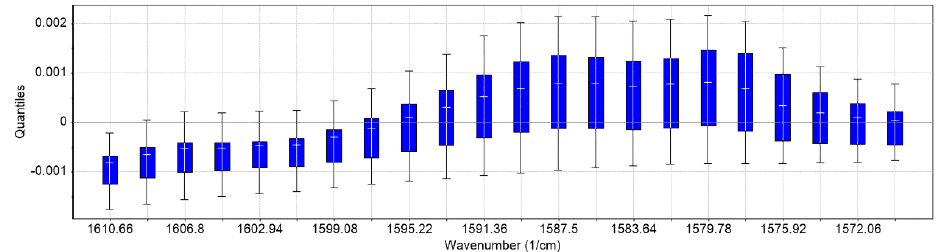
Figure 3. Boxplots (quantiles) of the training set. The maximum intensity deviation is observed in the region 1595–1575 cm −1 . the region 1595–1575 cm − 1